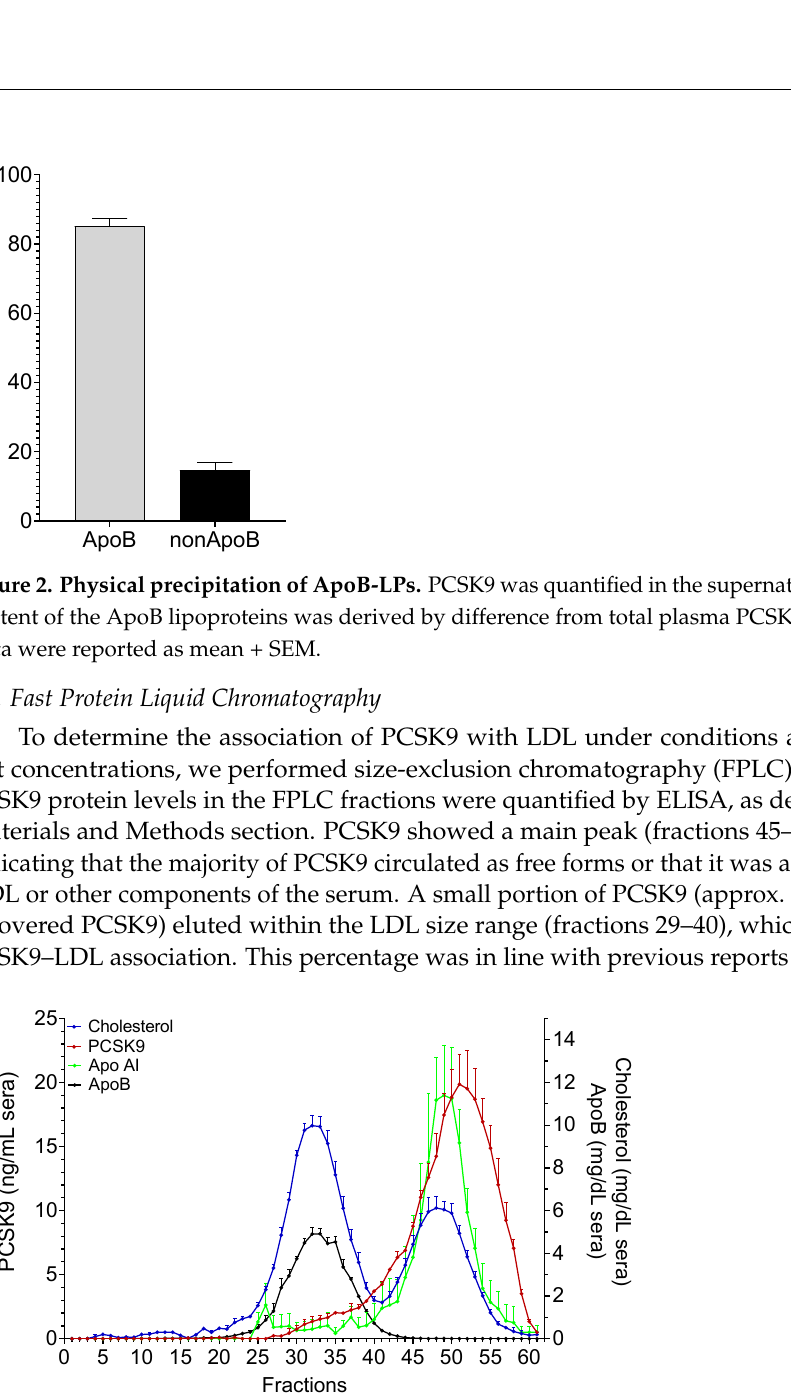
Figure 3. FPLC. Cholesterol, ApoB, Apo AI (n = 10) and PCSK9 (n = 7) profiles of FPLC fractions. Data were reported as mean + SEM.